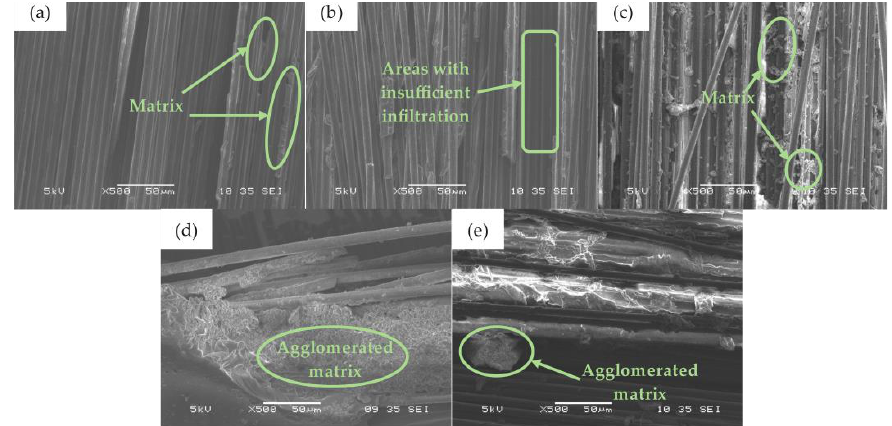
Figure 7. Infiltration structure of GO-CF/EP composites at different extrusion temperatures: ( a ) 30 °C, ( b ) 40 °C, ( c ) 50 °C, ( d ) 60 °C, ( e ) 70 °C.